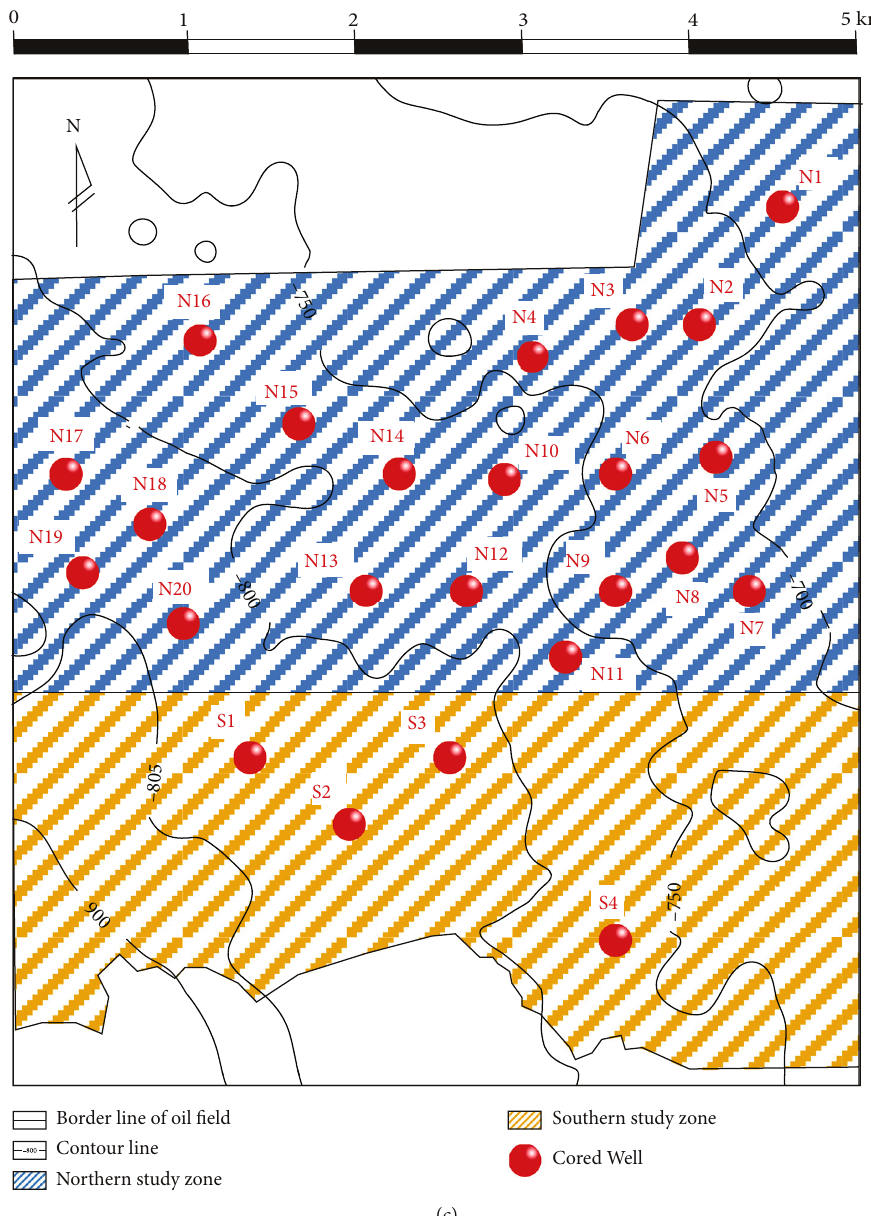
Figure 3: Geographic locations of the Ordos Basin (a) and study zone (b) and distribution of cored wells within the study zone